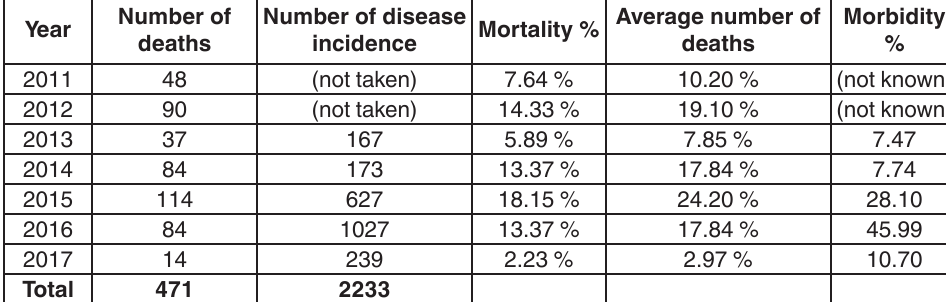
Table 3: Percent mortality and morbidity in different years